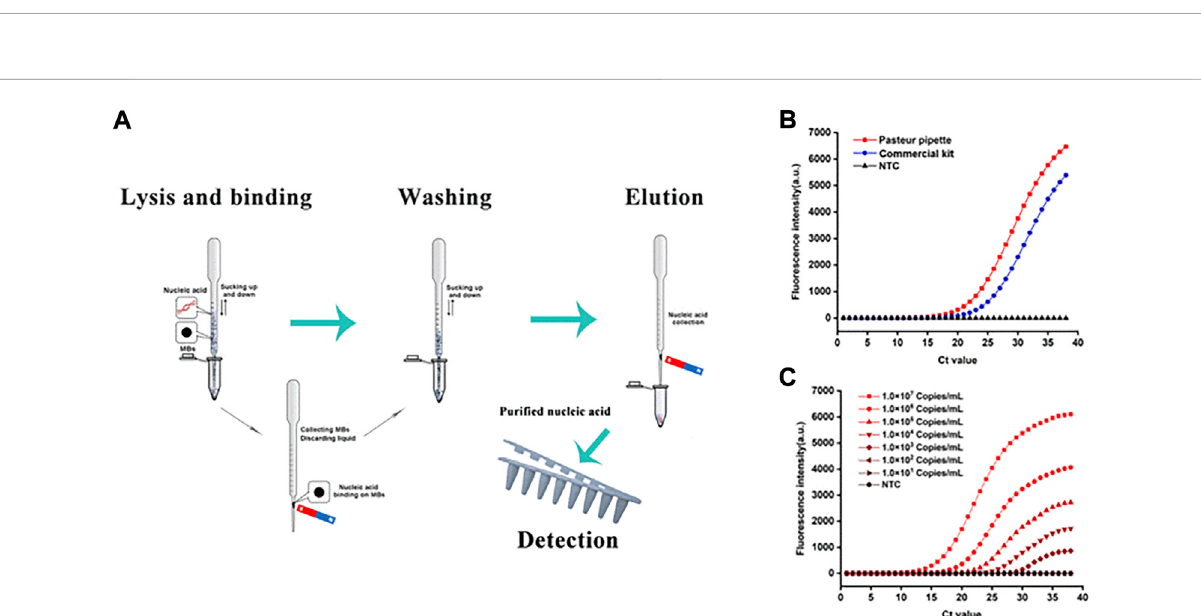
FIGURE 2 Nucleic acid extraction in Pasteur pipette system and detection results. (A) The schematic illustration of lysis and binding step, washing step, elution step and nucleic acid extraction in Pasteur pipette system, and detection step. (B) Comparison of extraction effect between Pasteur pipette system and the commercial kit. (C) The sensitivity of the Pasteur pipette system. Copyright 2021 Elsevier